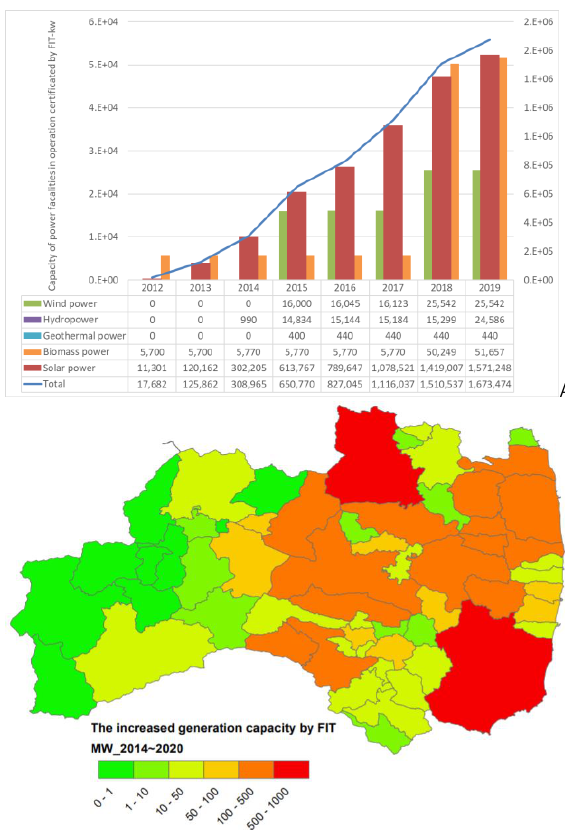
Figure 6. The renewable energy facilities certificated by FIT scheme on: (A), the trend of annual total capacities of plants